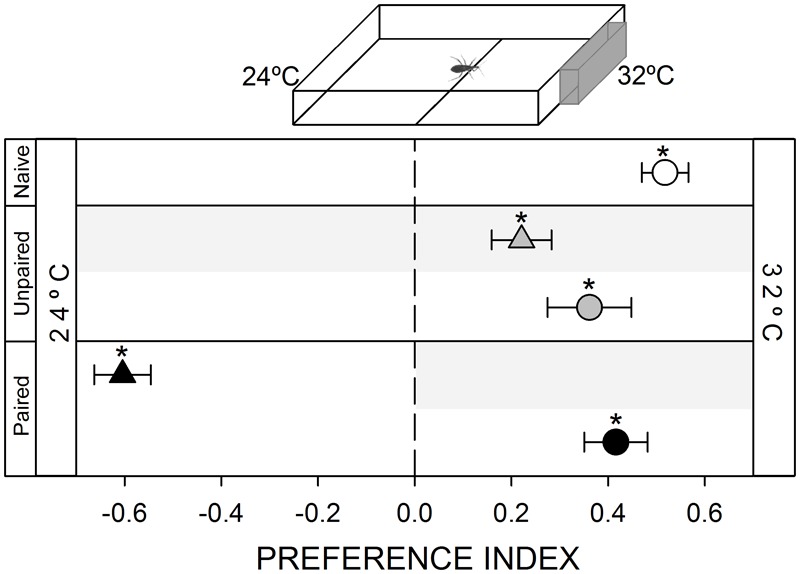
Responses of R. prolixus to a thermal stimulus. A 32°C heated plate was attractive for naïve insects (white circle, p < 0.05). Unpaired yoke controls presented the same pattern: i.e., attraction to heat (gray triangle and circle, p < 0.05 in both cases). During training, insects avoided the punished zone: i.e., the hot side (black triangle, p < 0.05). During test insects continued to prefer the hot side (black circle, p < 0.05), evincing that this attraction was not modulated by the aversive conditioning. Each point represents the mean (±SE) spatial preference of 30 insects individually released in a 2-choice rectangular walking arena. Asterisks denote statistical differences between the PI and the value 0 (p < 0.05) evinced by One sample T-test. Gray shadows show the zone in which punishment was delivered during unpaired and paired trainings.